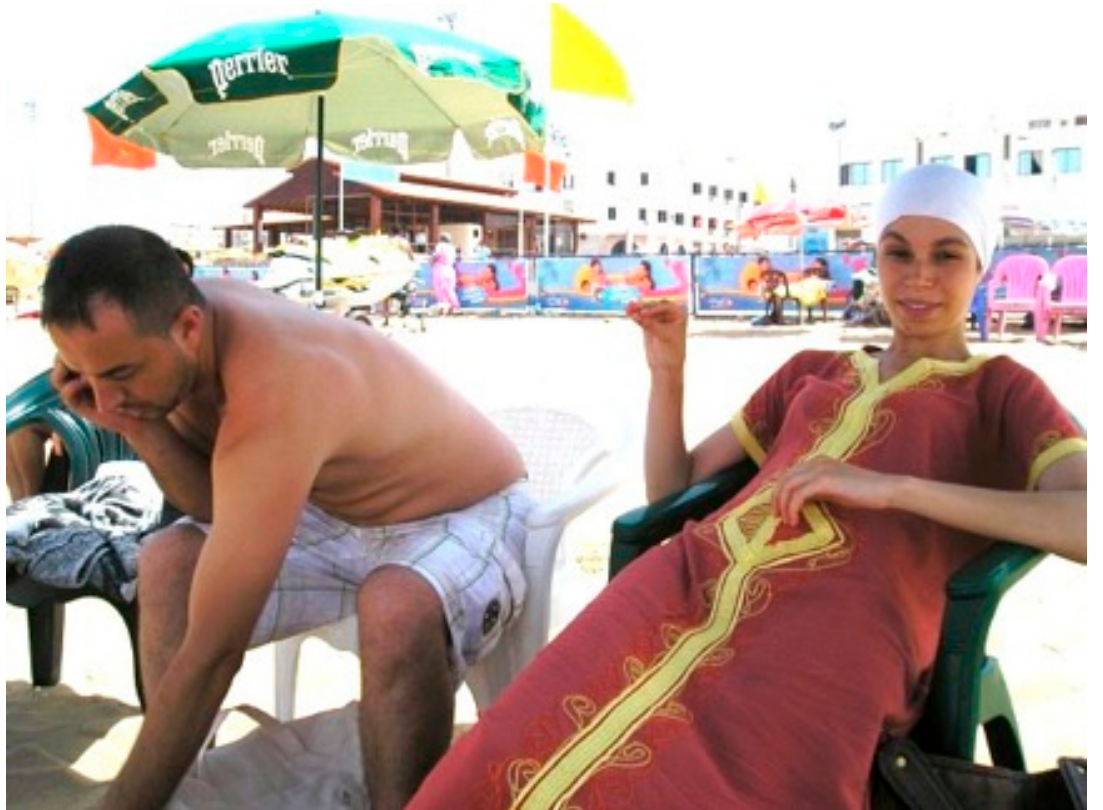
Figure 1. This participant still wears her gondorra, while her friend has his folded on the chair next to him. The woman in bright pink in the distant background is also wearing a gondorra over layers (used with permission).